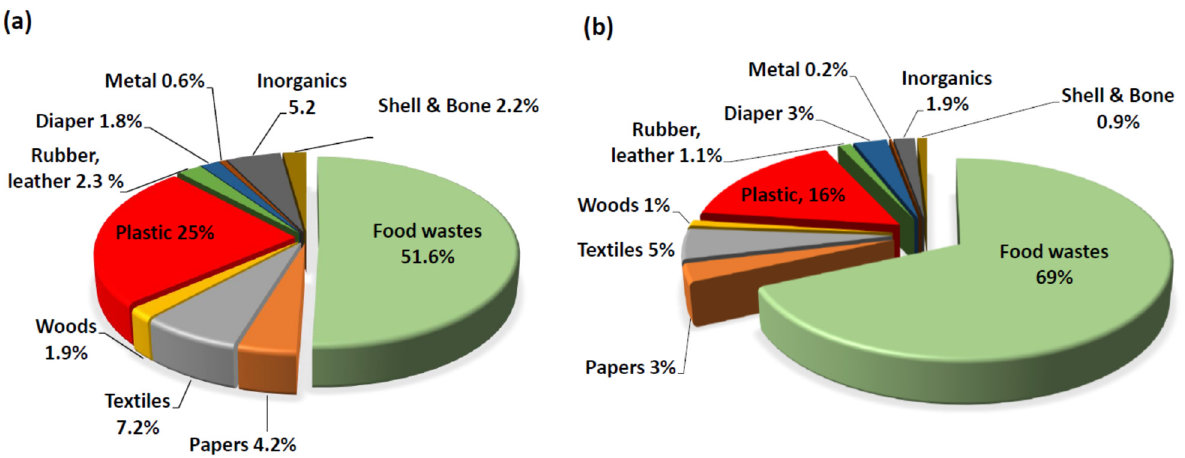
Figure 4. Physical composition of MSW in Ho Chi Minh City ( a ) dry weight-basis and ( b ) wet weight-basis (in percentage) (Data source: DONRE 2009 [17]).